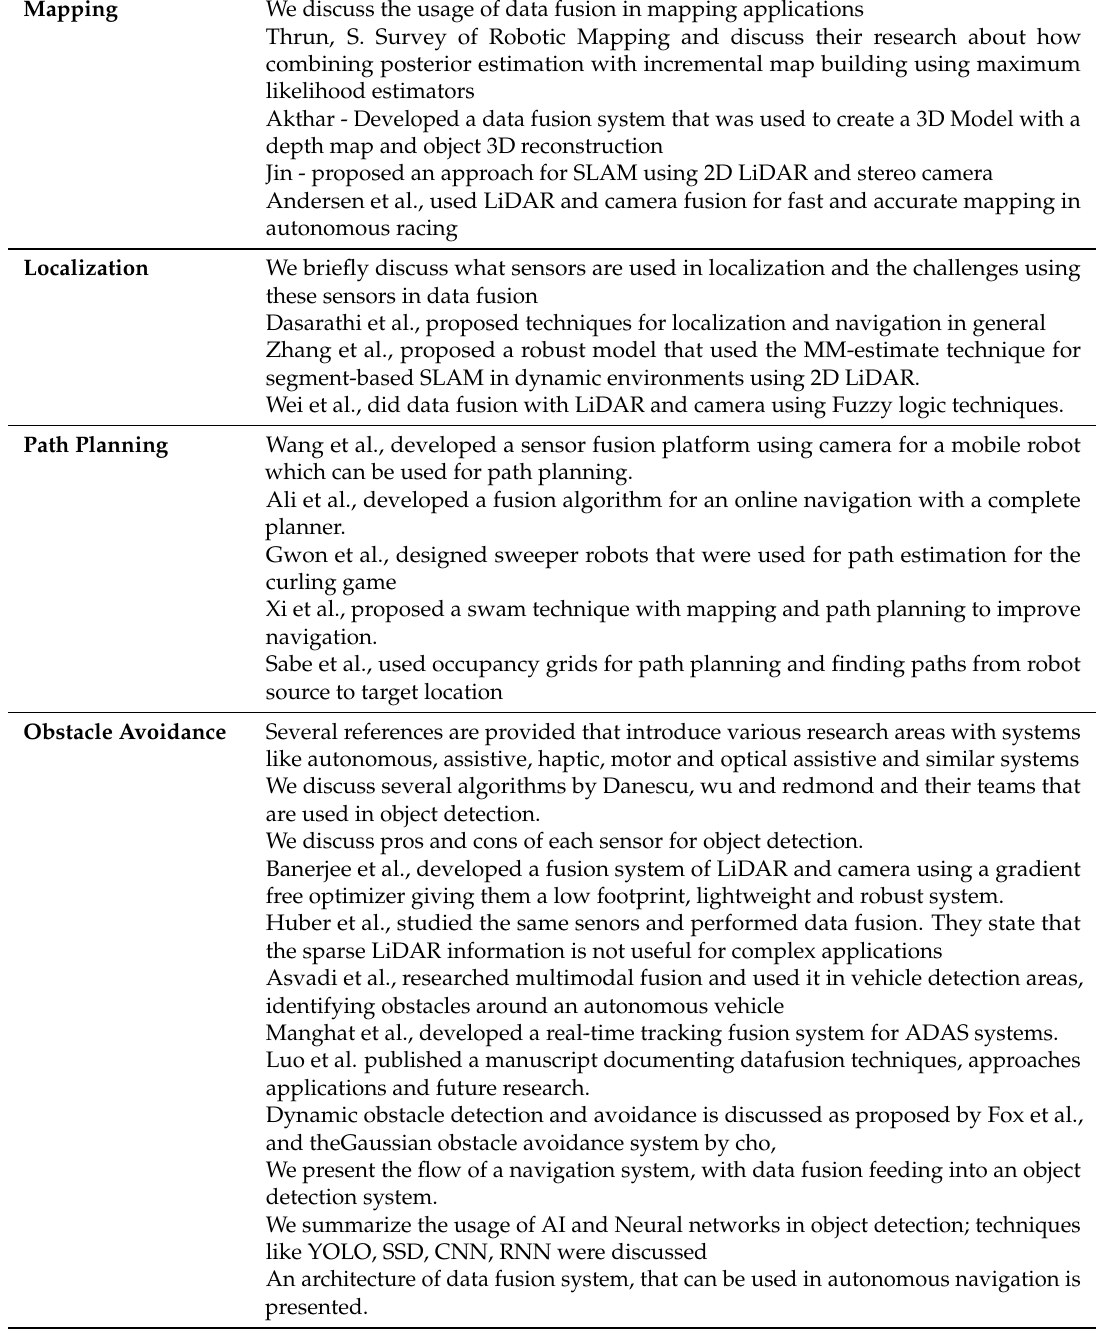
Table 3. Summary of the usage of data fusion techniques in autonomous navigation. Summary of the Usage of Data Fusion Techniques in Autonomous